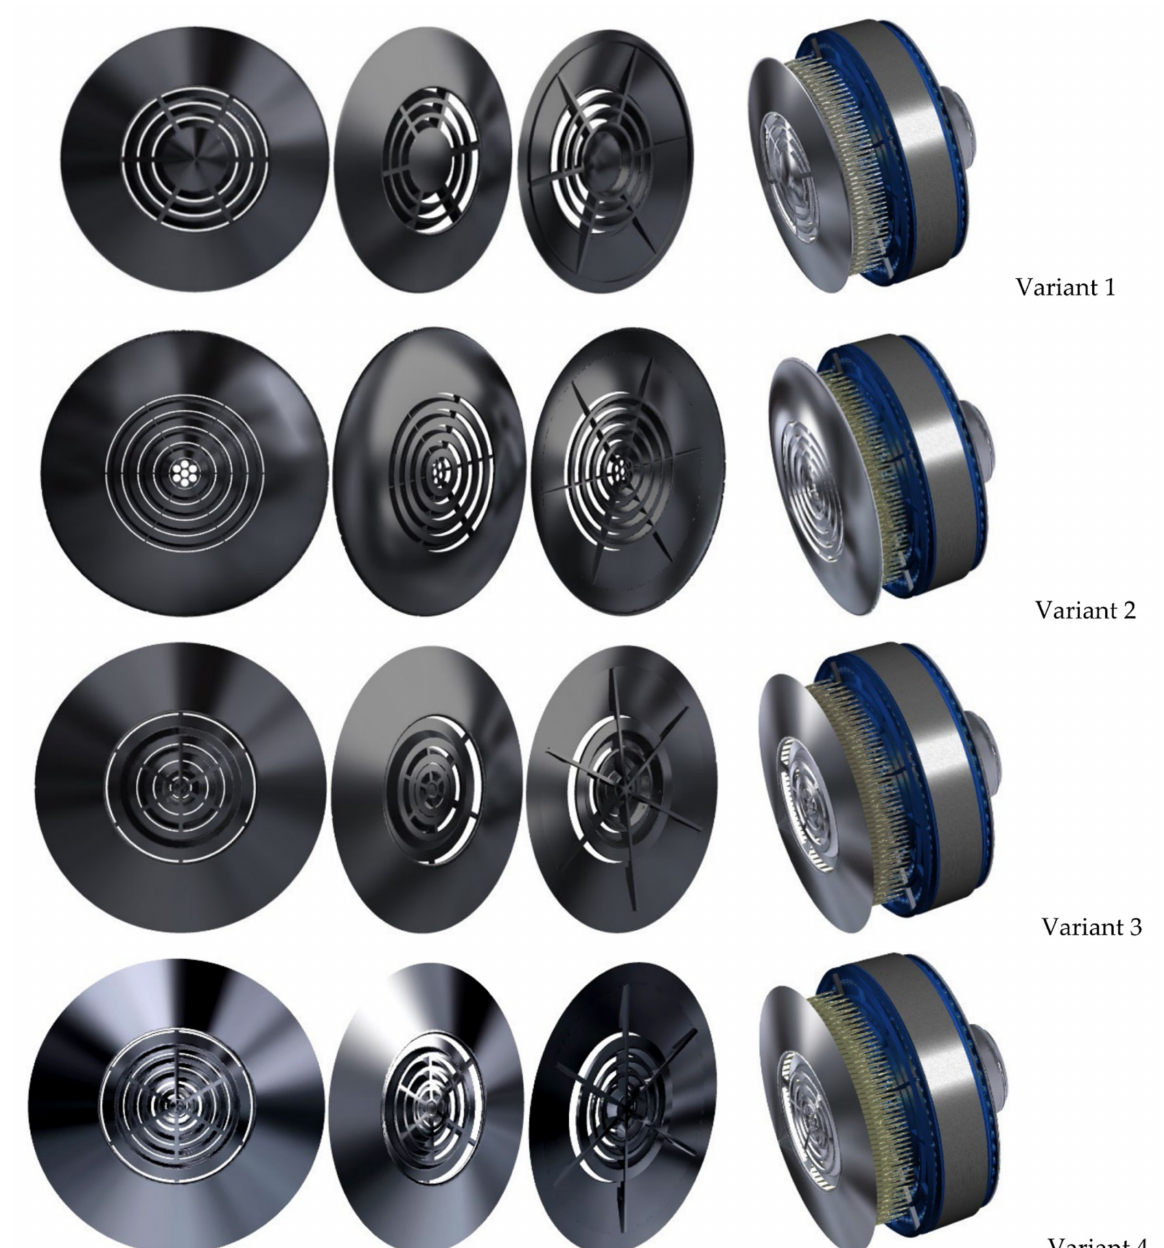
Figure 9. Four variants of canister